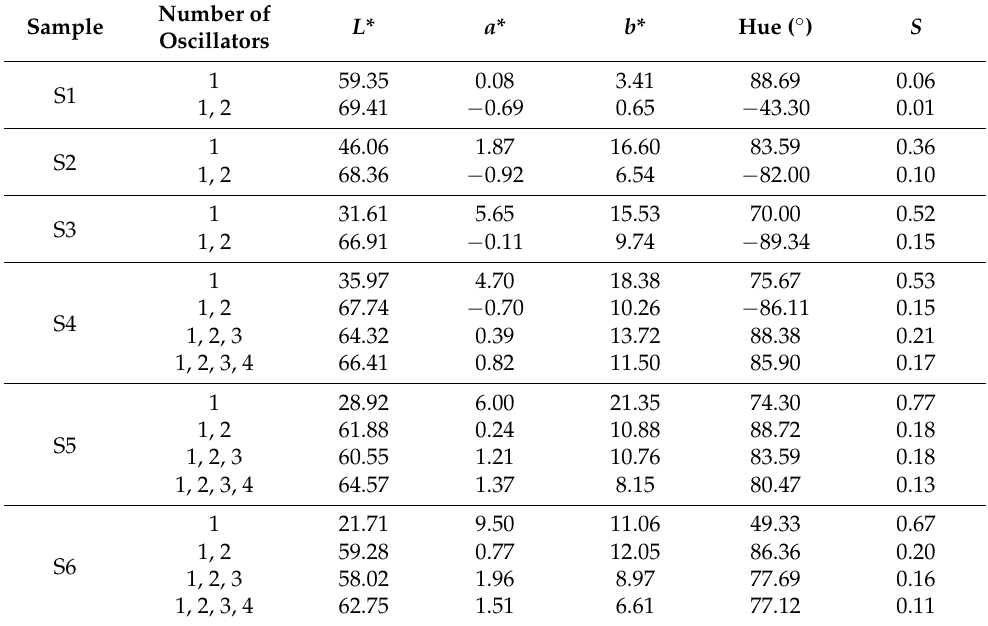
Table 1. Colorimetric parameters of S1–S6 with increasing the number of Lorentz oscillators. Number of Sample